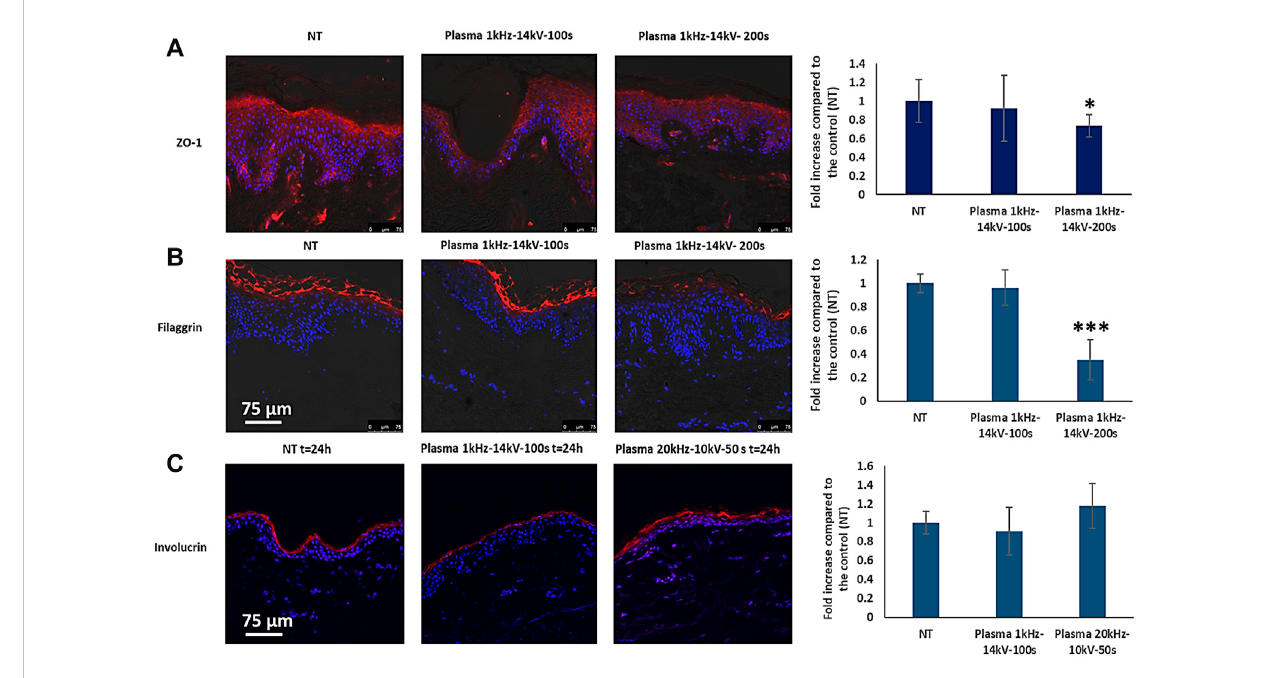
FIGURE 4 Protein fl uorescence images for (A) ZO-1, (B) fi laggrin, and (C) involucrin. The right-hand side histograms plot the fold increase of the fl uorescence signal for the two plasma exposure conditions versus the control group (NT)